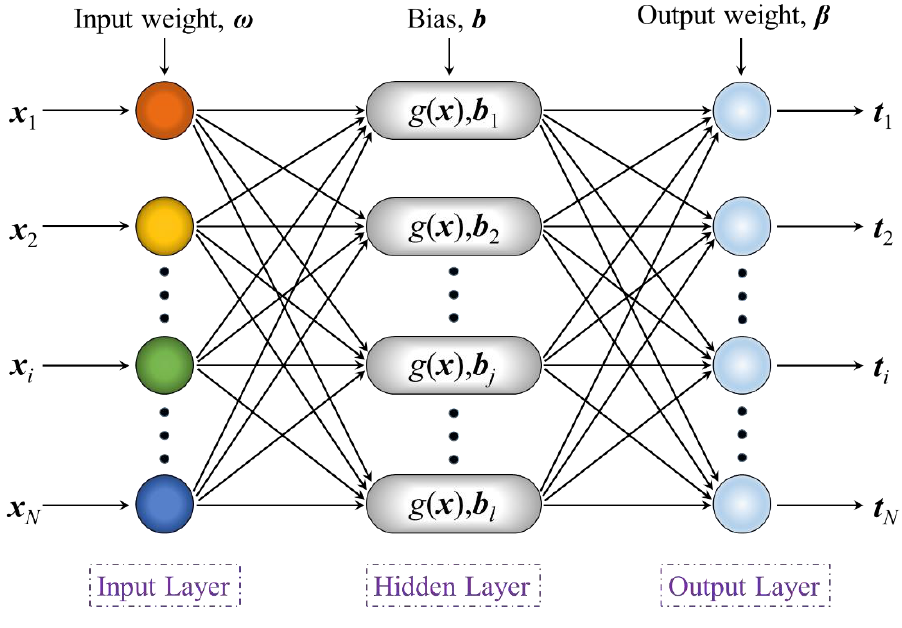
H where is the output matrix of the hidden layer in ELM.